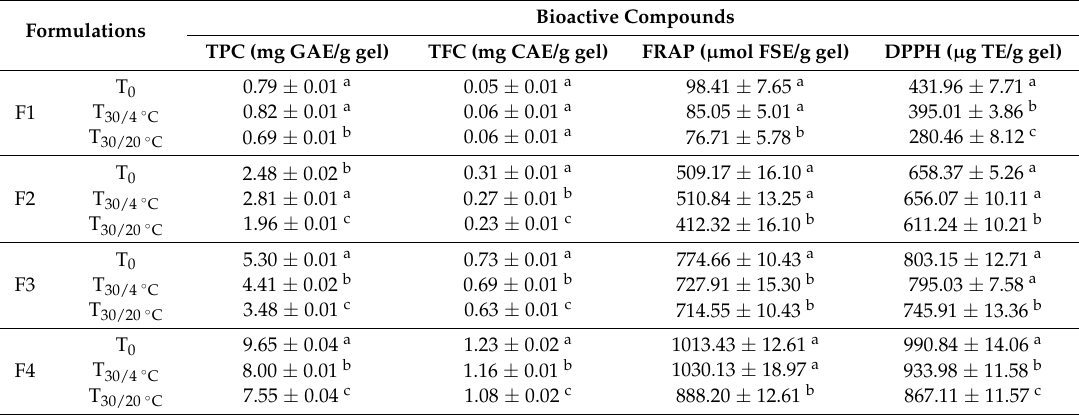
Table 3. Total phenolic content (TPC), total flavonoid content (TFC), ferric reducing antioxidant power (FRAP) and 2,2-diphenyl-1-picrylhydrazyl (DPPH ) scavenging assay of hydrogels containing chestnut bur extracts in different percentages, evaluated at different times and temperatures (mean ± standard deviation, n = 3). T 0 , time 0. T 30/4 ◦ C , after 30 days at 4 ◦ C. T 30/20 ◦ C , after 30 days at 20 ◦ C. GAE, gallic acid equivalents. CAE, catechin equivalents. FSE, ferrous sulphate equivalents. TE, Trolox equivalents.